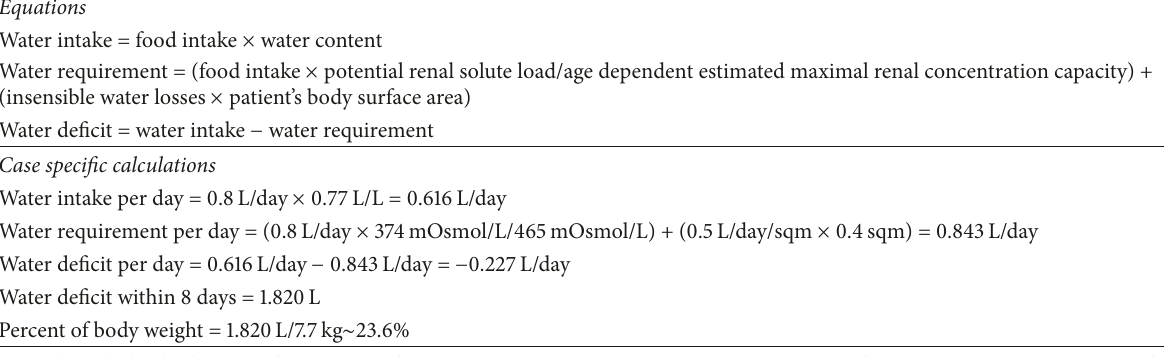
Table 3: The patient’s calculated water deficit over the last 8 days prior to admission to the pediatric intensive care unit.